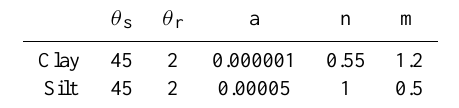
Figure 13b. Variation of the soil permeability in point A